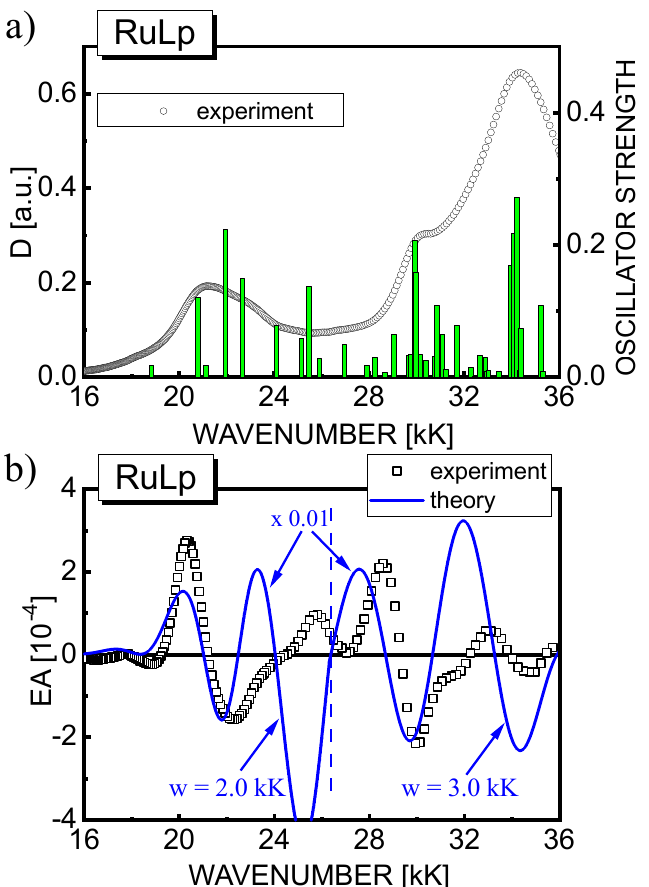
Figure 10. ( a ) Stick − bar spectrum of the calculated oscillator strengths using the TDDFT method for RuLp(PF 6 ) 2 in a free space overlaid on the experimental absorption spectrum of the RuLp(PF 6 ) 2 film (circles); ( b ) The EA spectrum calculated using the TDDFT method for all excited states presented in part (a) of the figure (solid line) compared with the experimental EA spectrum of the film (squares). The EA signals were calculated assuming the same Gaussian bandwidths: w = 2 kK for all excited states in the lower energy range and w = 3 kK in the higher energy range, as indicated by the vertical dashed line separating the two areas.